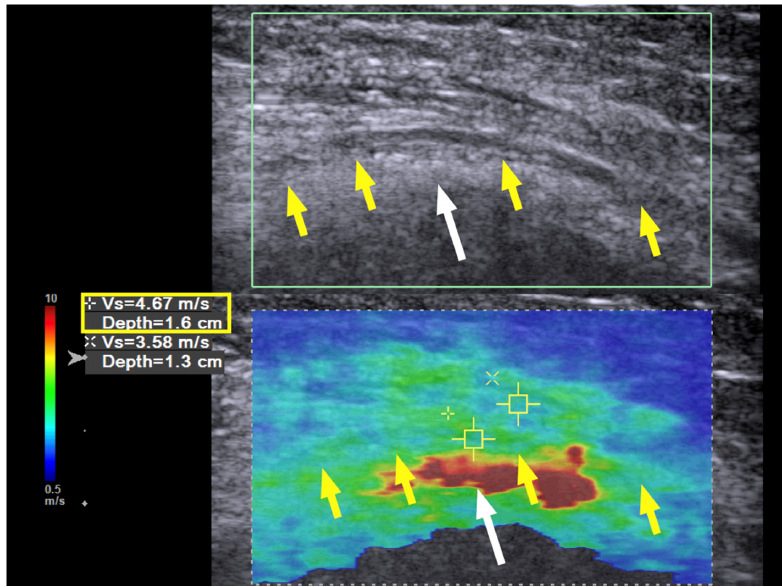
4 Figure 4. Case 1: Shear wave velocity nine months after hydrodissection. Shear wave velocity (SWV) investigation of the radial nerve (long axis) over the spiral groove. Nine months after the first hydrodissection, the hardness of the nerve has returned to near normal, with a shear wave velocity of 4.67 m / s. Yellow arrow and box: radial nerve in longitudinal view; white arrow: bony cortex of humerus.